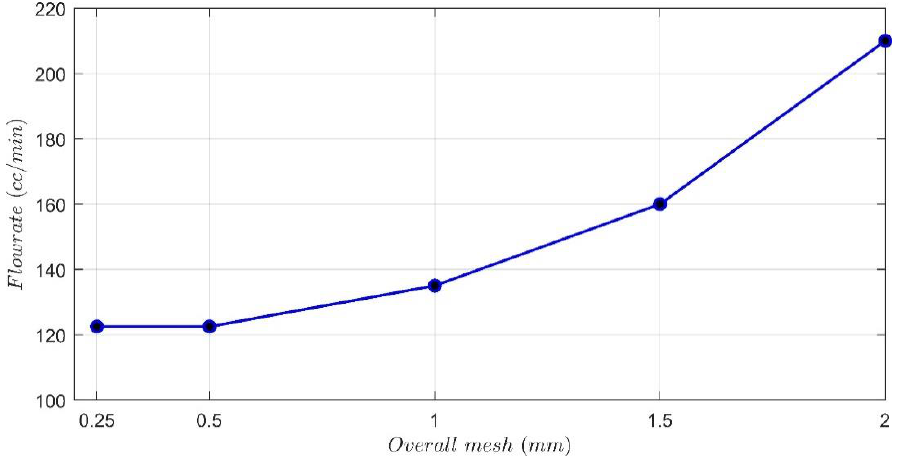
Figure 6. Effect of mesh sensitivity on the flow rate.